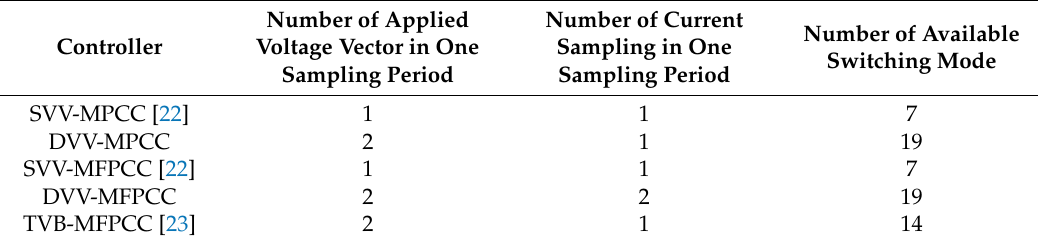
Table 4. The differences between five predictive current